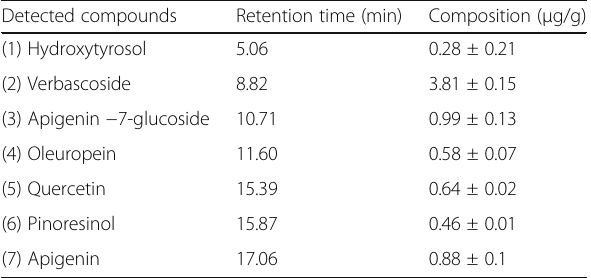
Table 4 Identification and quantification of phenolic compounds of ethanol extract from leaves of Cynara scolymus by using HPLC analysis